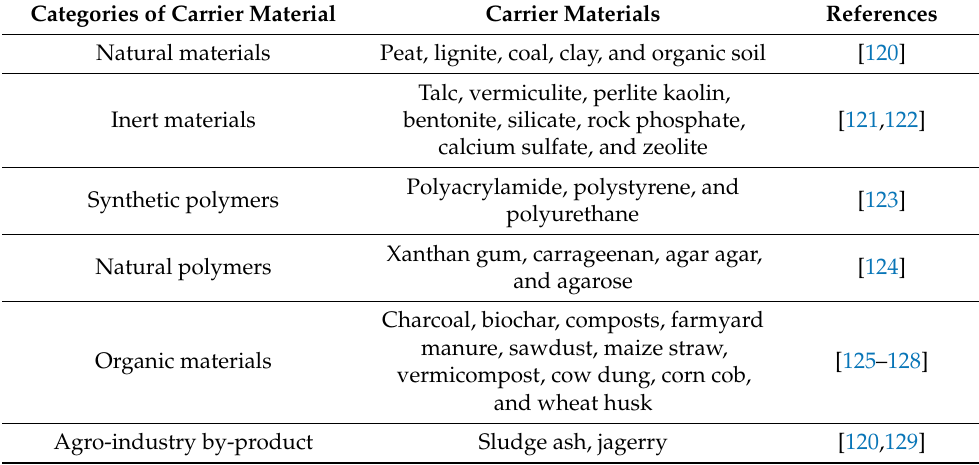
Table 3. Classification of carrier materials for the production of